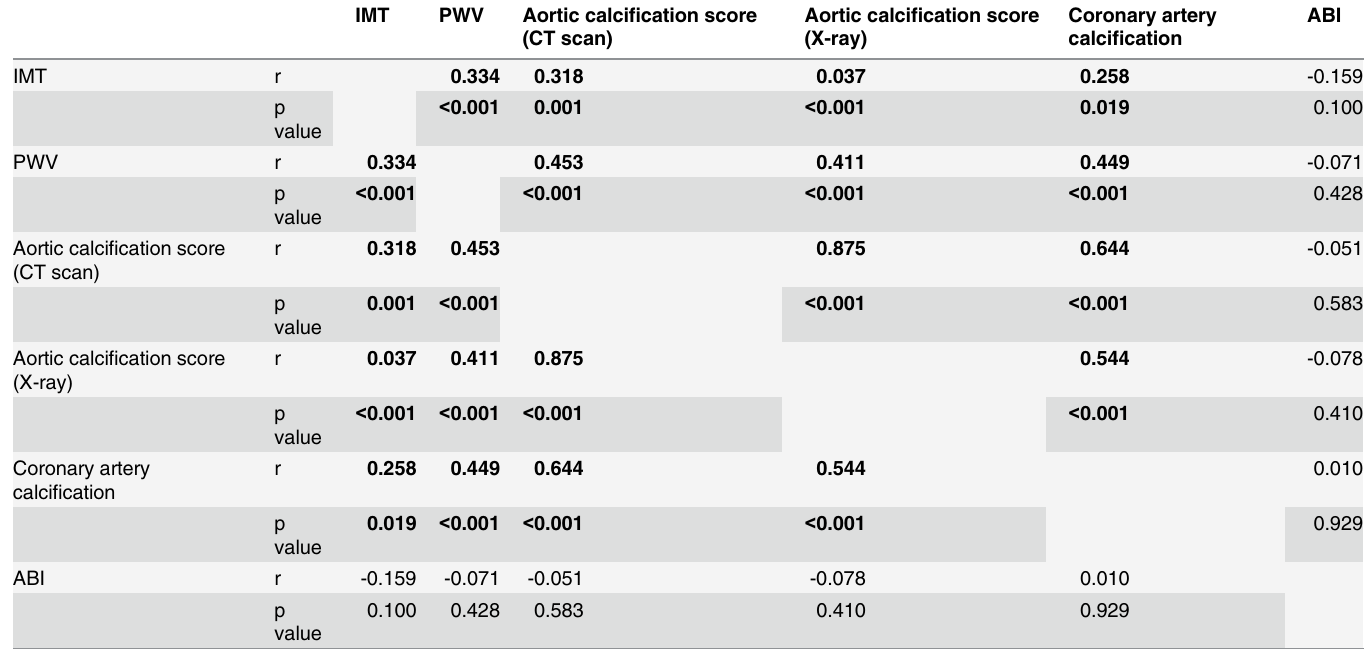
Table 2. Correlation between non-invasive